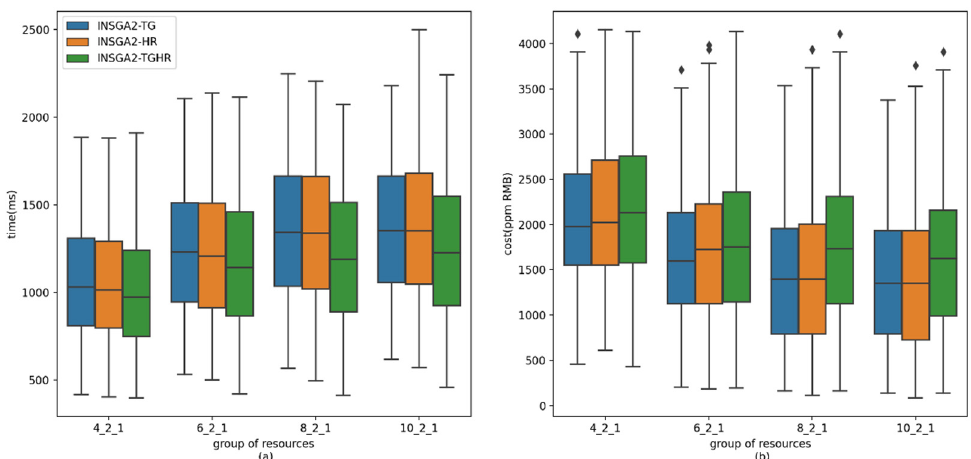
Figure 10. The boxplot in different local resources setting. ( a ) Comparing the effect of local resources setting on time; ( b ) Comparing the effect of local resources setting on cost. The rhombus symbols represent outliers, which are also the same in Figures 12, 14 and 16 in the later text.